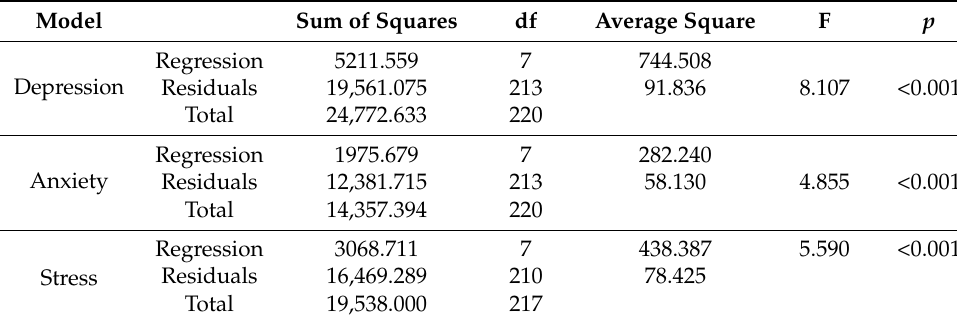
Table 6. ANOVA Depression, Anxiety, and Stress. Model Sum of Squares